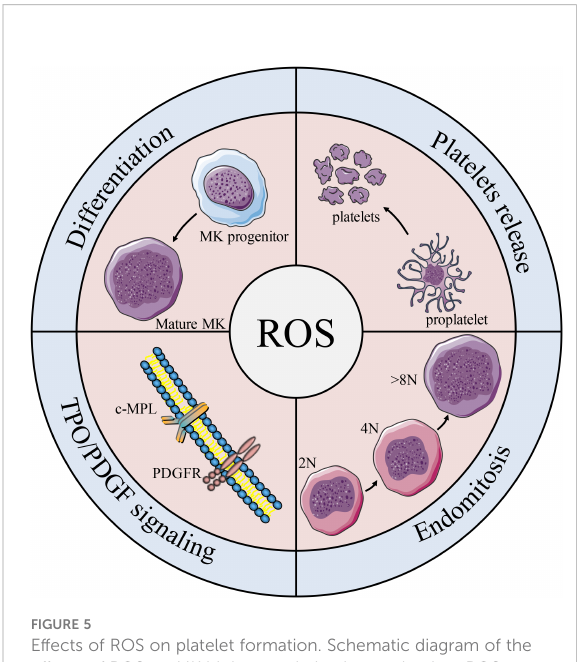
FIGURE 5 Effects of ROS on platelet formation. Schematic diagram of the effects of ROS on MK biology and platelet production. ROS participates in the differentiation of MK progenitors into MKs, and plays an important role in regulating c-MPL/PDGFR pathway, MK mitosis and platelet